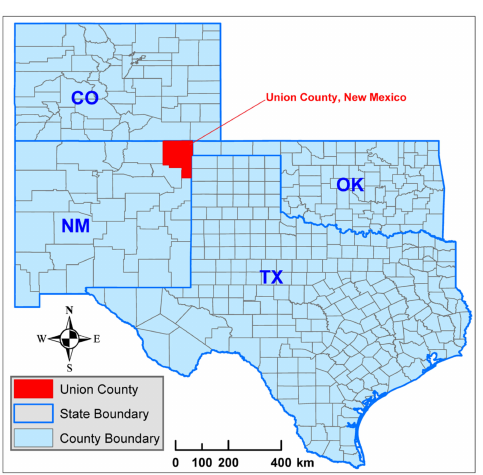
Figure A1. The relative geographic location of Union County, New Mexico, in the broader region. Note: the local landscape features mainly natural grassland and (mostly irrigated) crop agriculture. Data source: US